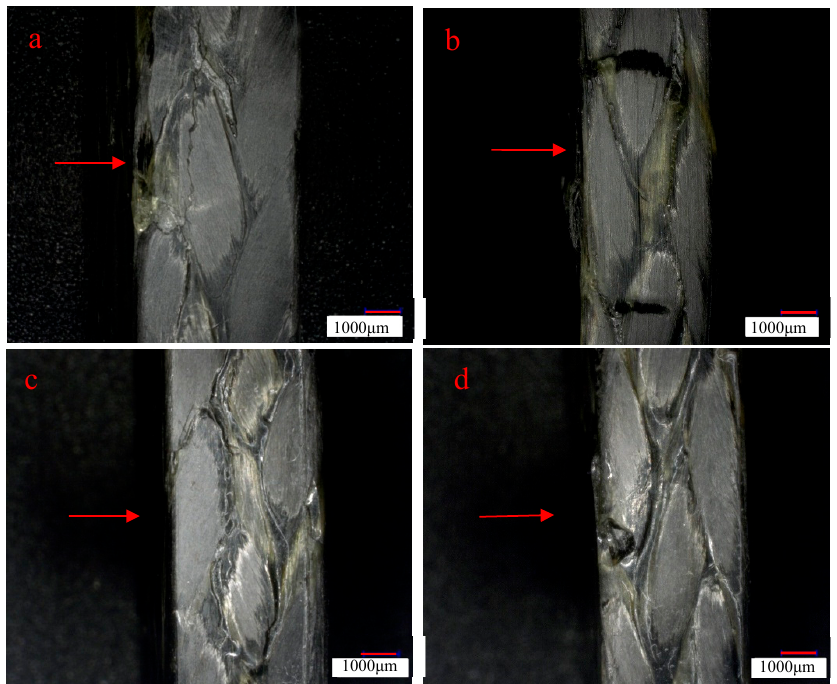
Figure 10. Lateral morphology of bending fracture of 3Dim–5Dir braided composites at 110 °C with different durations ( a ) at room temperature; ( b ) 110 °C 0.25 h; ( c ) 110 °C 10 h; ( d ) 110 °C 30 h.